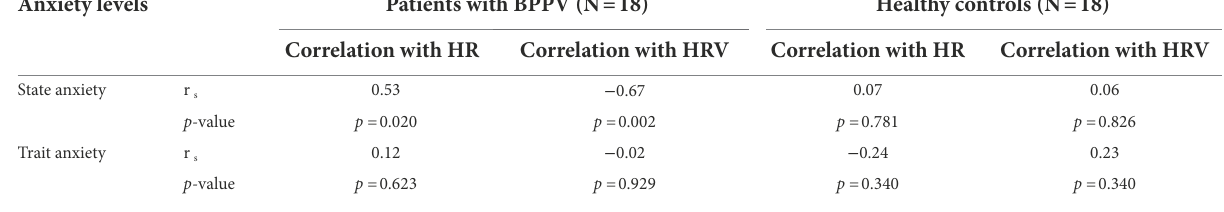
TABLE 3 Correlations between anxiety levels and heart-rate/heart-rate variability measures in patients with BPPV and in healthy controls. Anxiety